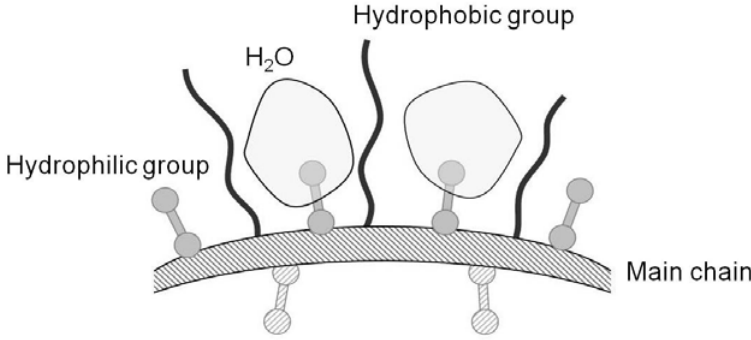
Figure 4. Illustration of the interaction between water and Chitosonic ® Acid molecules.